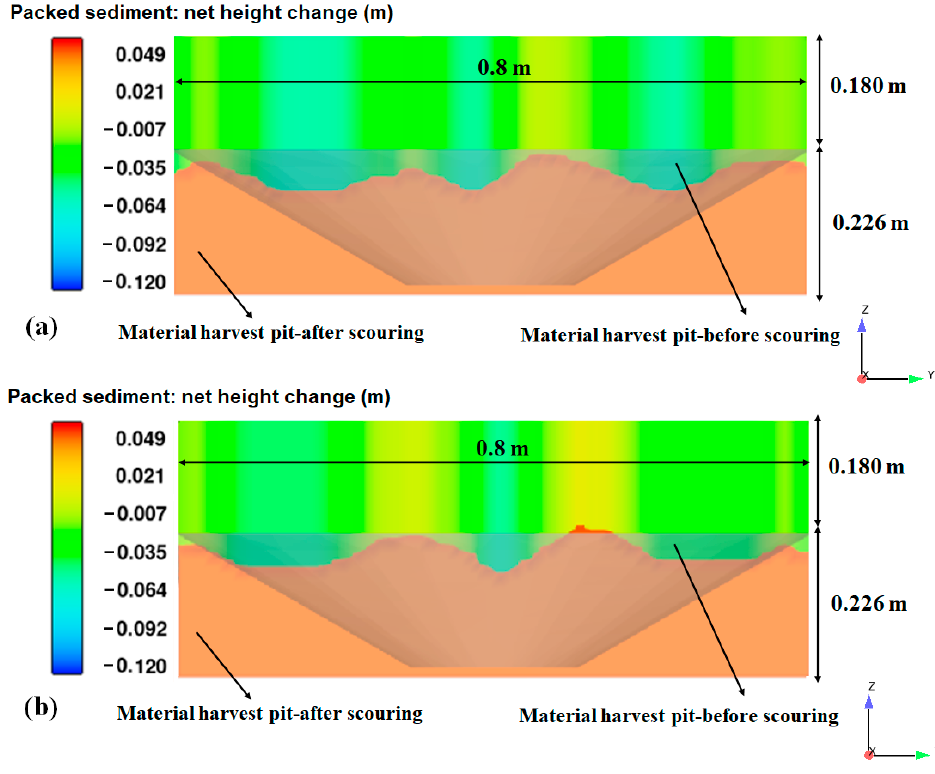
Figure 13. Changes in the harvest pit in the y–z plane: ( a ) Circular model; ( b ) hydrodynamic model.